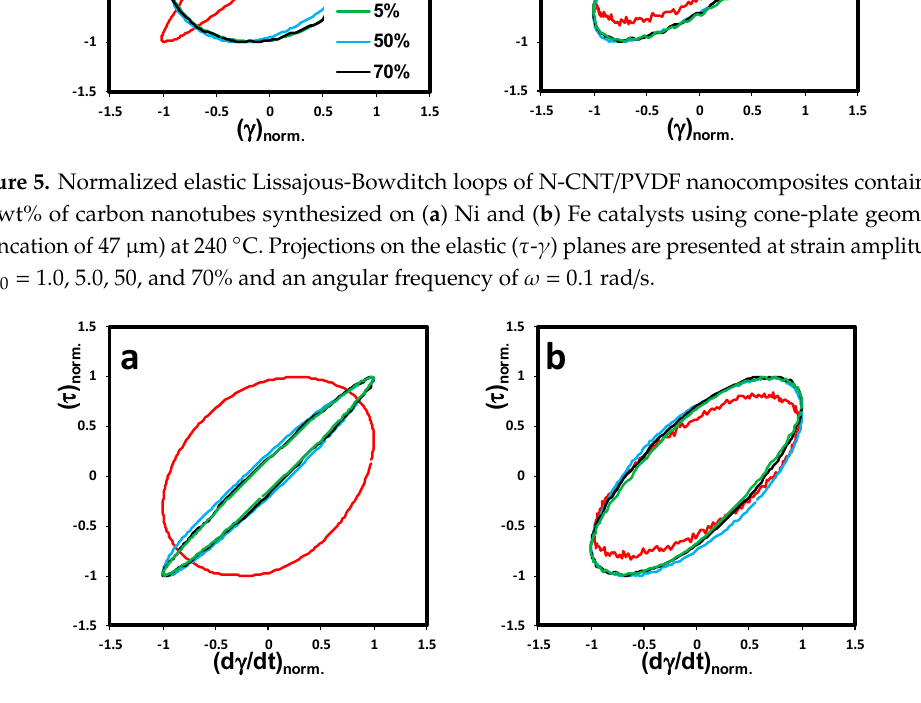
Figure 6. Normalized viscous Lissajous-Bowditch loops of N-CNT / PVDF nanocomposites containing 2.0 wt% of carbon nanotubes synthesized on ( a ) Ni and ( b ) Fe catalysts using cone-plate geometry (truncation of 47 µ m) at 240 ◦ C. Projections on the viscous ( τ - ) planes are presented at strain amplitudes of γ 0 = 1.0, 5.0, 50, and 70% and an angular frequency of ω = 0.1 rad / s.